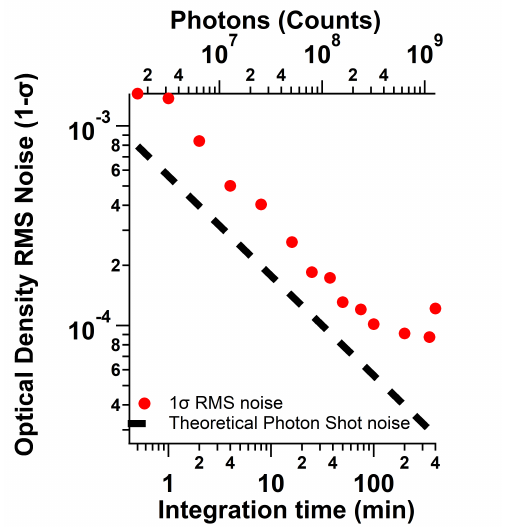
Figure 9. Signal-to-noise evaluation for the spectrometer evaluated as the 1- σ RMS noise. The RMS noise levels off at longer integration